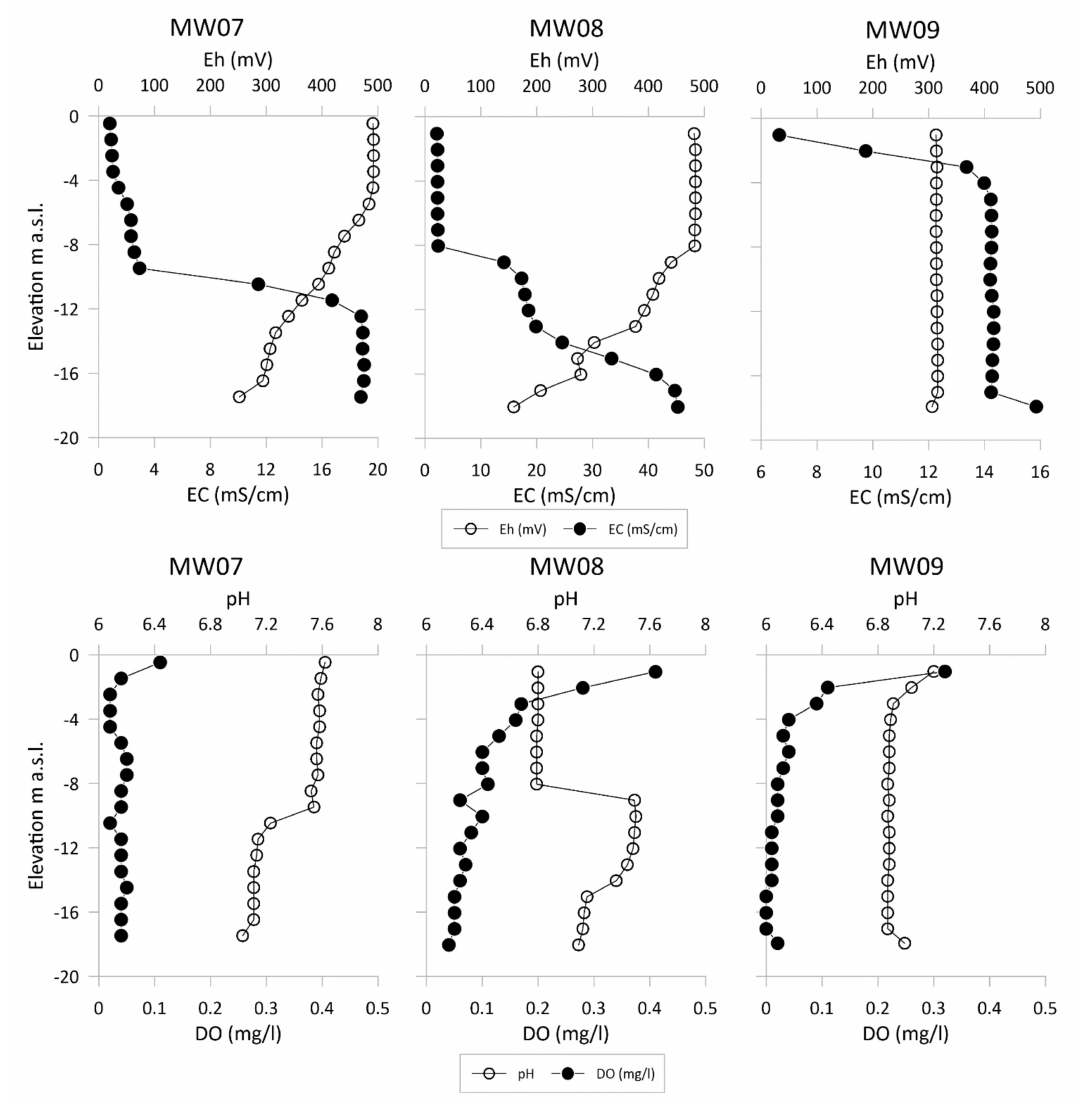
Figure 2. (Upper panel) Electrical Conductivity (black dots) and redox potential (empty dots) vertical profile in MW07, MW08, and MW09, (Lower panel) Dissolved Oxygen (black dots) and pH (empty dots) vertical profile in MW07, MW08 and